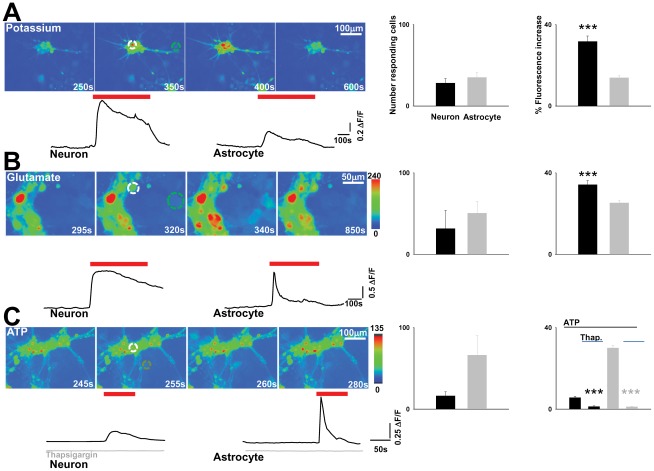
Neurons and astrocytes respond to chemical stimulation.
A. Images taken at different stages during an experiment illustrating responses to increased potassium. Traces below plot fluorescence over the time course for indicated neuron (white circle) and astrocyte (green circle). Bargraphs to the right display the number of neurons and astrocytes responding with calcium elevations to potassium and the amplitude of fluorescence increase in the two different cell populations. B. Images illustrating calcium elevations in response to glutamate. Responses from the neuron (white circle) and astrocyte (green circle) are plotted in the traces below. Bargraphs to the right display the number of neurons and astrocytes responding with calcium elevations to glutamate and the amplitude of fluorescence increase in the two different cell populations. C. Images illustrating calcium elevations in response to ATP. Responses from the neuron (white circle) and astrocyte (green circle) are plotted in the traces below. Grey traces show responses following thapsigargin treatment. Bargraphs to the right display the number of neurons and astrocytes responding with calcium elevations to ATP and the amplitude of fluorescence increase in the two different cell types in control conditions and following thapsigargin treatment. Cells were used within 14 days of differentiation.